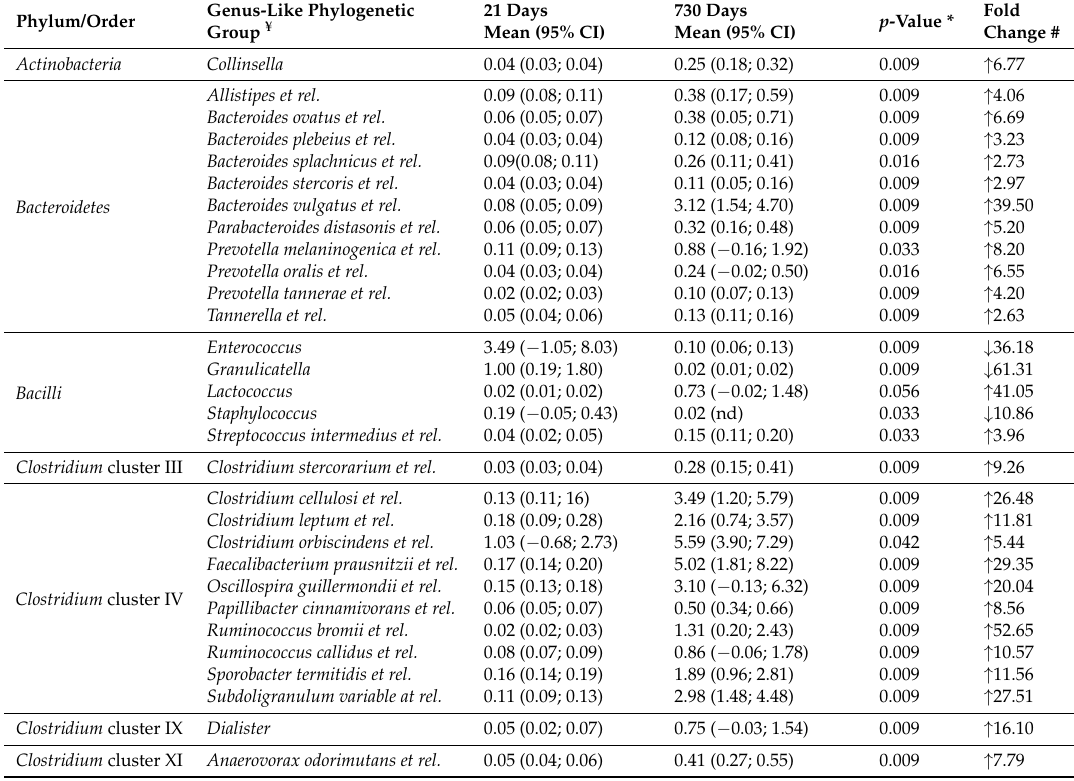
Relative counts of genus-like bacterial groups. The genus-like phylogenetic groups (Level 2; [39]), detected in fecal samples, collected at 21 days and 2 years after birth, from preterm infants, are shown a